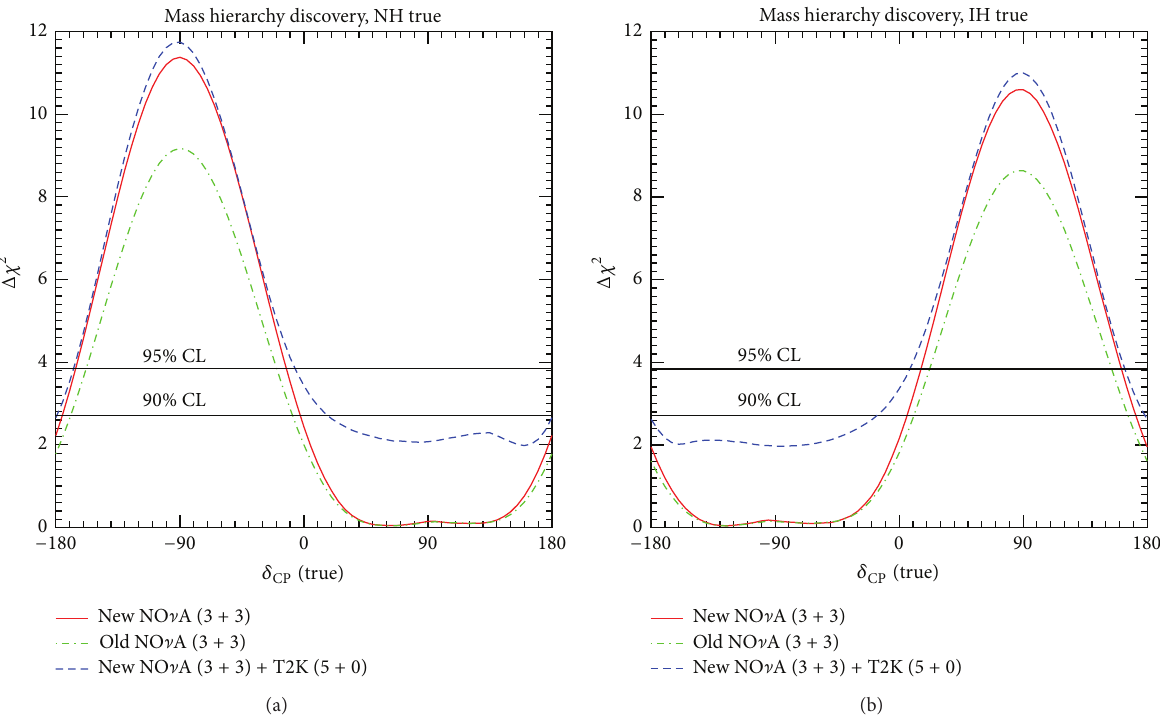
assuming NH (IH) as CP